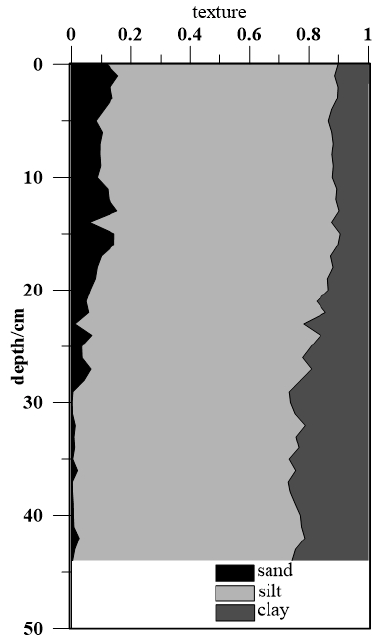
Figure 2. Changes of sediment grain size with depth.